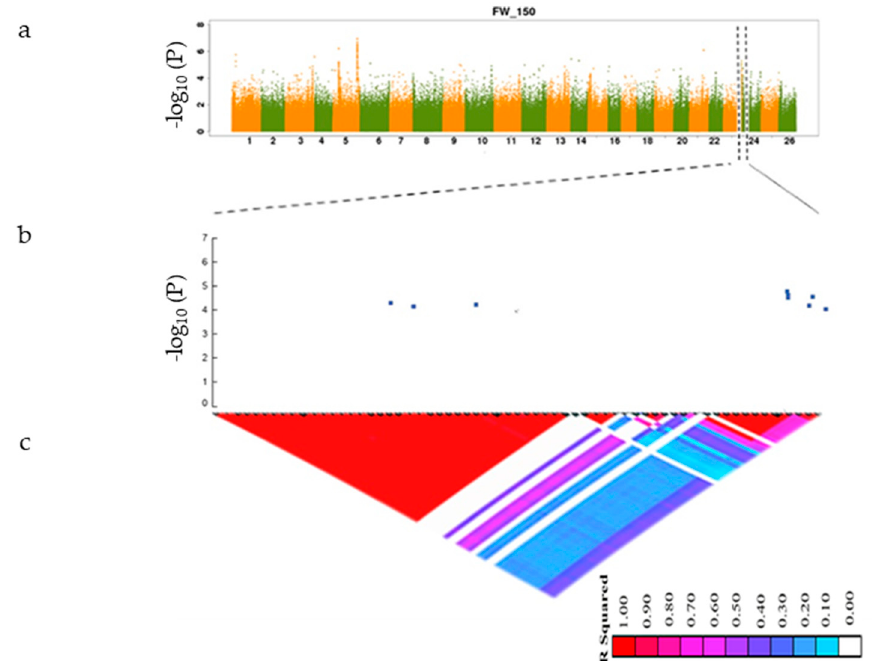
Figure 5. ( a ) Manhattan plot of FW_150. FW_150 is the value of leaf freshwater content under salt stress conditions. The X-axis denotes twenty-six chromosomes and the y-axis depicts − log10 p -value; ( b ) local Manhattan plot across the region of chromosome D10 where SNPs were found to be significantly associated with FW_150; the y-axis is − log10 p -value; ( c ) linkage disequilibrium block heatmap of FW_150 triangles shows the r 2 value of SNPs; the red color indicates 1 and the white color indicates 0.